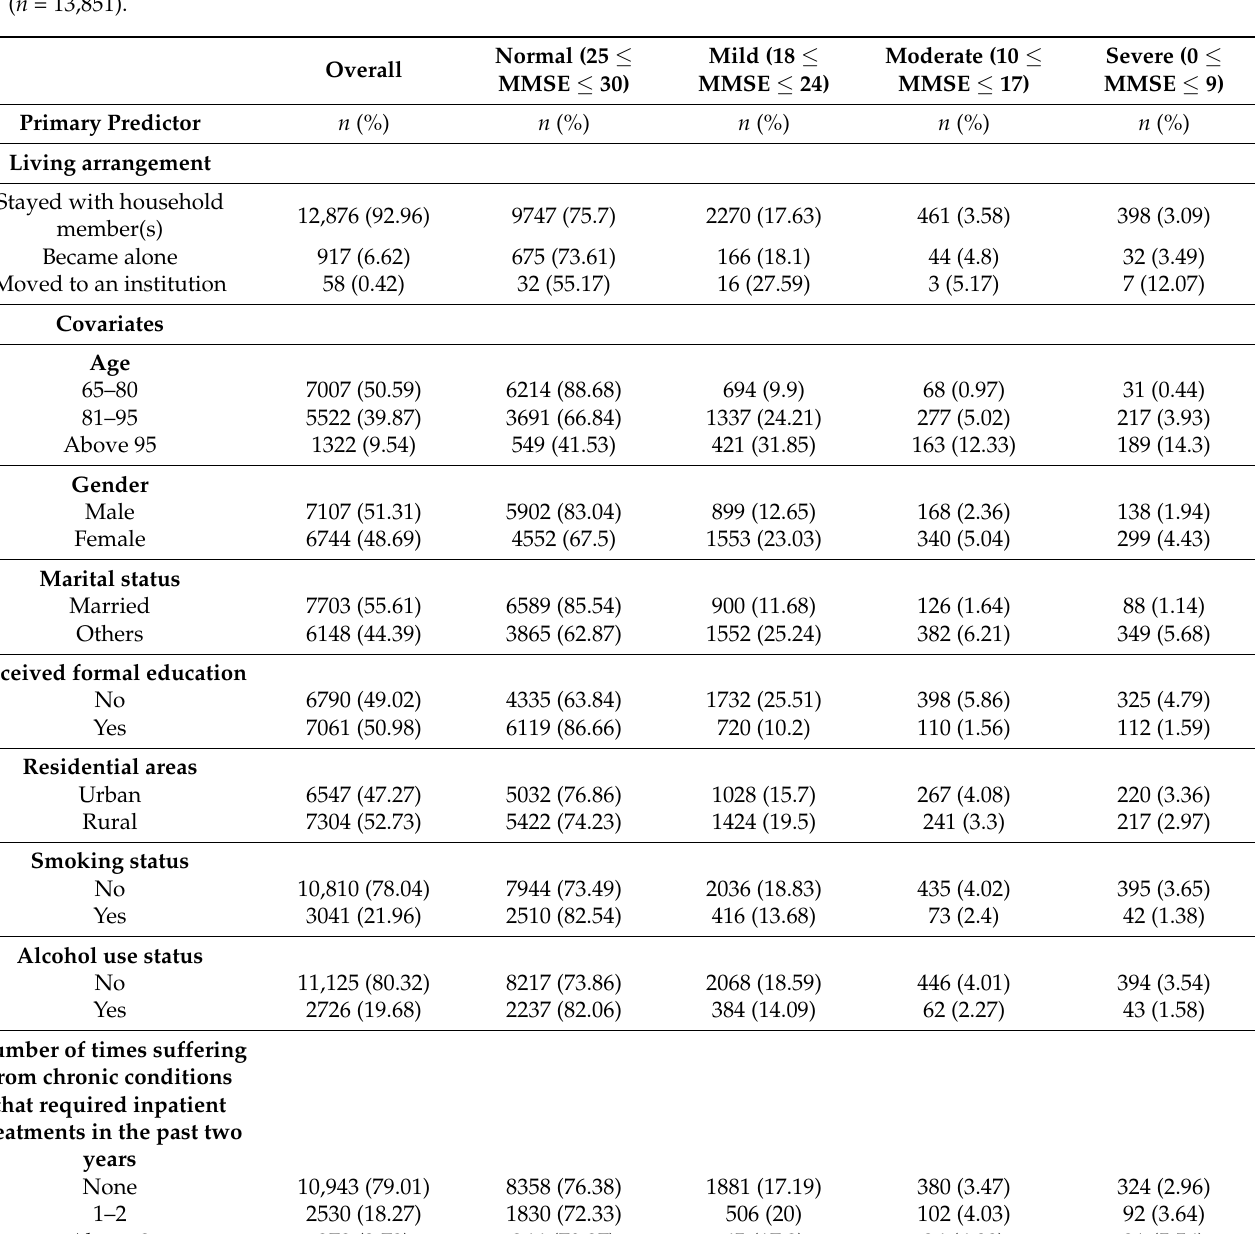
Table 1. Sample characteristics of the final study sample: the Chinese Longitudinal Healthy Longevity Survey, 2009–2014 ( n =